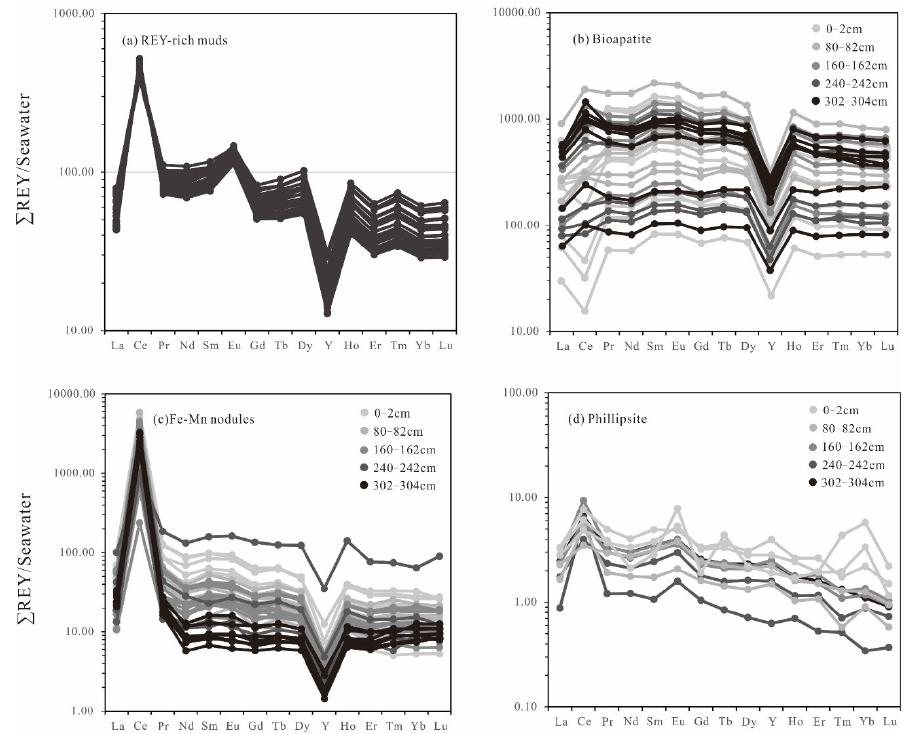
Figure 7. Seawater-normalized REY patterns for ( a ) REY-rich muds, ( b ) bioapatite, ( c ) Fe–Mn micronodules, and ( d ) phillipsite. Normalizing values are from [32].